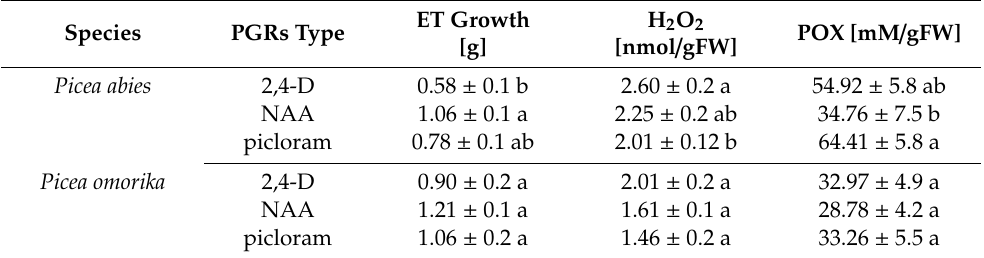
Table 3. The growth intensity, level of H 2 O 2 and guaiacol peroxidase (POX) activity in embryogenic lines of Picea abies and P. omorika in relationship to the PGR type used during the induction of the ET lines. (mean ± standard error). Di ff erent letters within columns indicate statistically significant di ff erences between means for PGRs type within species ( p <